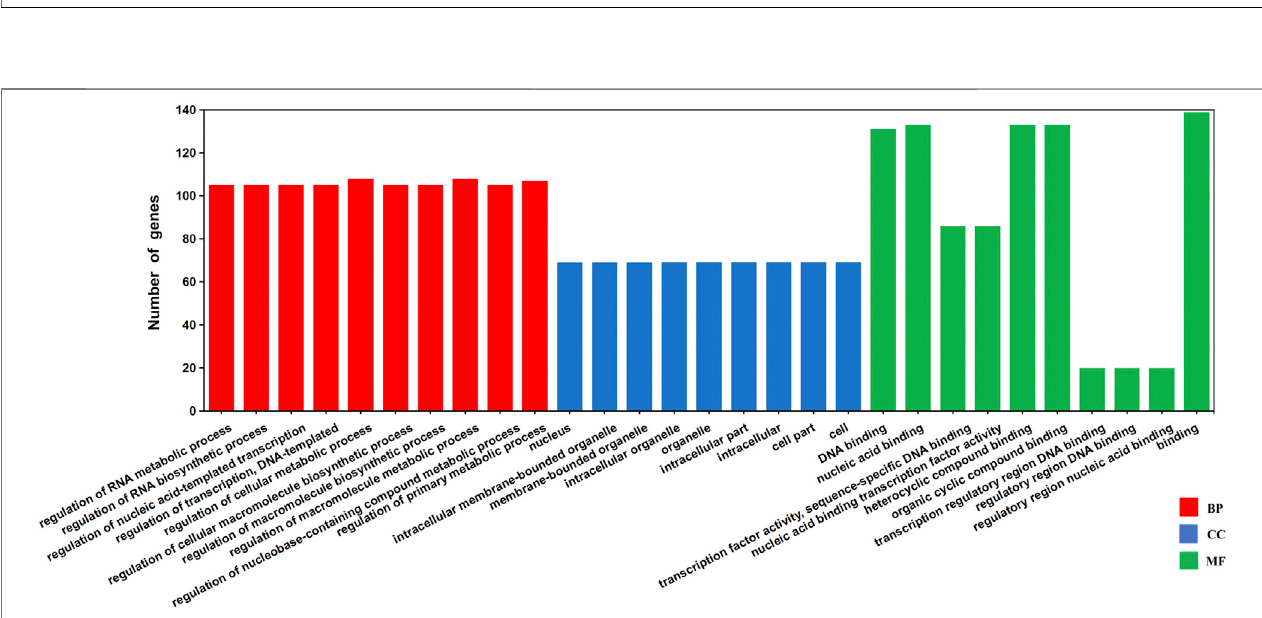
FIGURE 4 | Expression patterns of six subfamilies of GhJMJ genes between NEC and EC tissues based on qRT-PCR. Three independent experiments were performed; the error bars indicated the SDs. *, **, and *** indicate signi fi cant differences compared with the control (NEC) at p < 0.05, p < 0.01 and p < 0.005, respectively, according to the Student ’ s t-test.